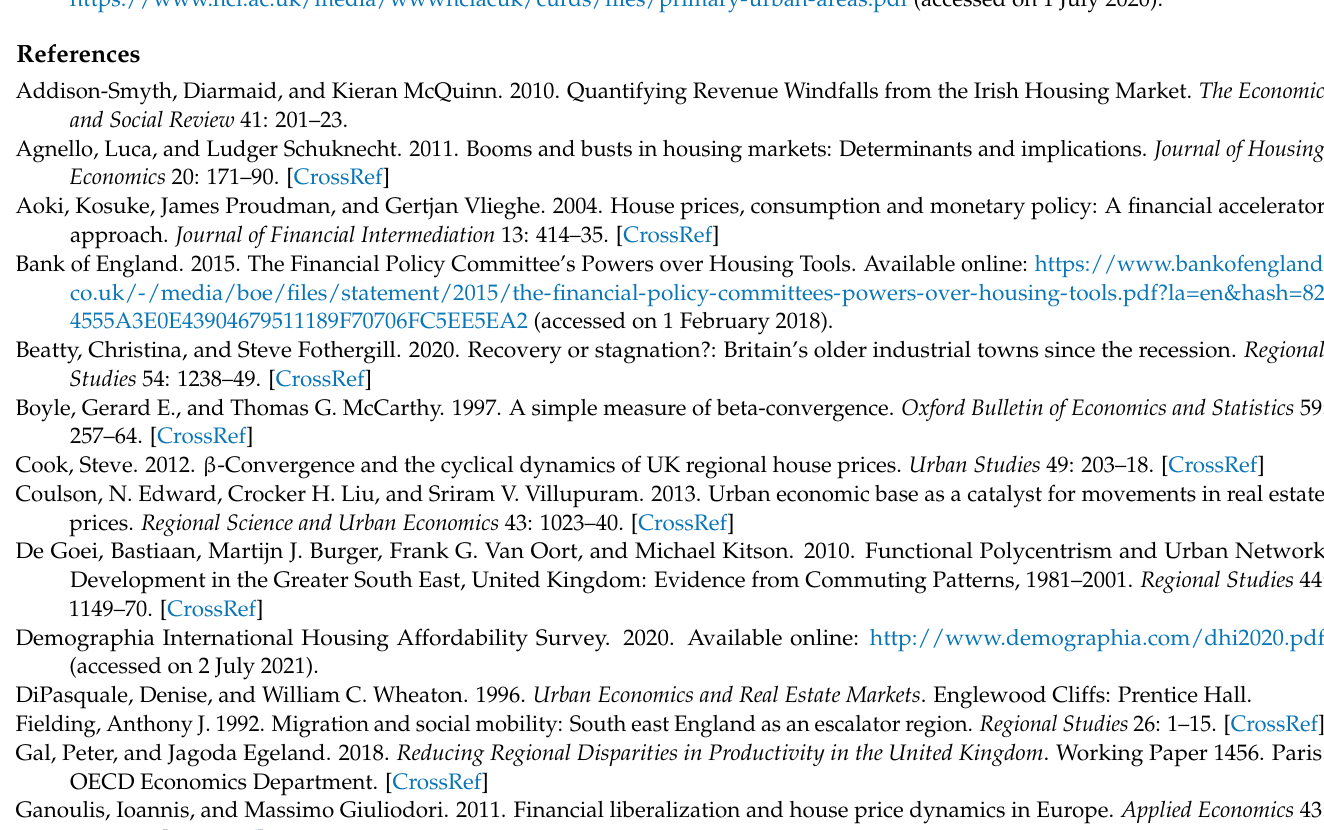
Table 29 Housing market: simple average house prices, mortgage advances and incomes of borrowers, by new/other dwellings, type of buyer and standard statistical region, from 1969 (previously DCLG table 515)